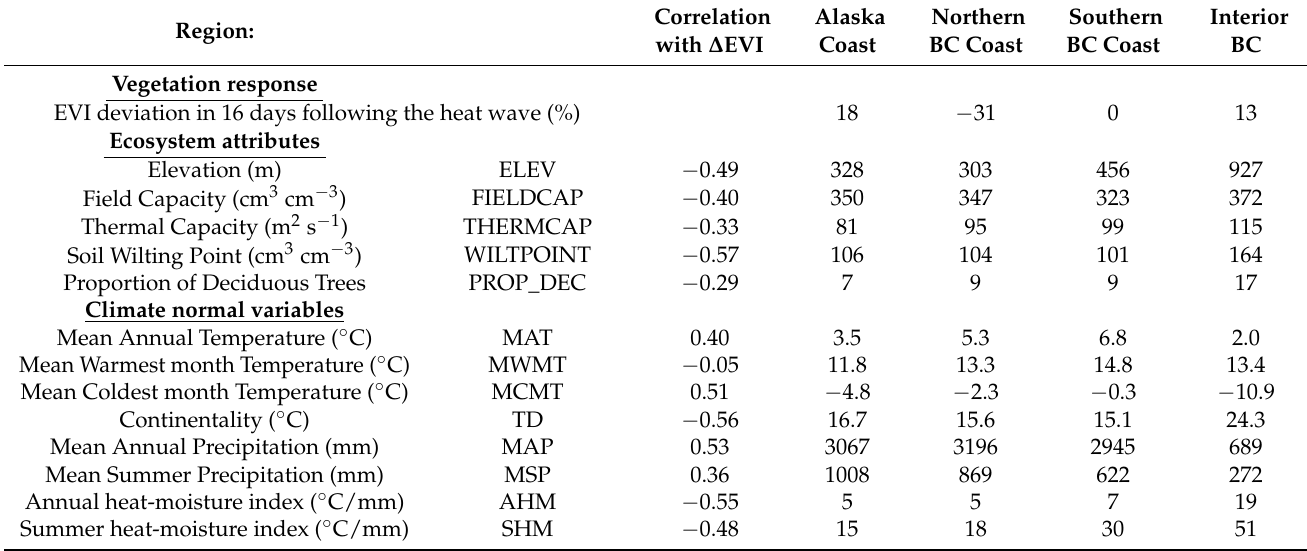
4. Discussion Although temperatures such as those observed during the 2021 western North American heat wave are expected to lead to a loss of photosynthesis in boreal and sub-boreal forest tree species, as shown in [45], this was notably not observed in this